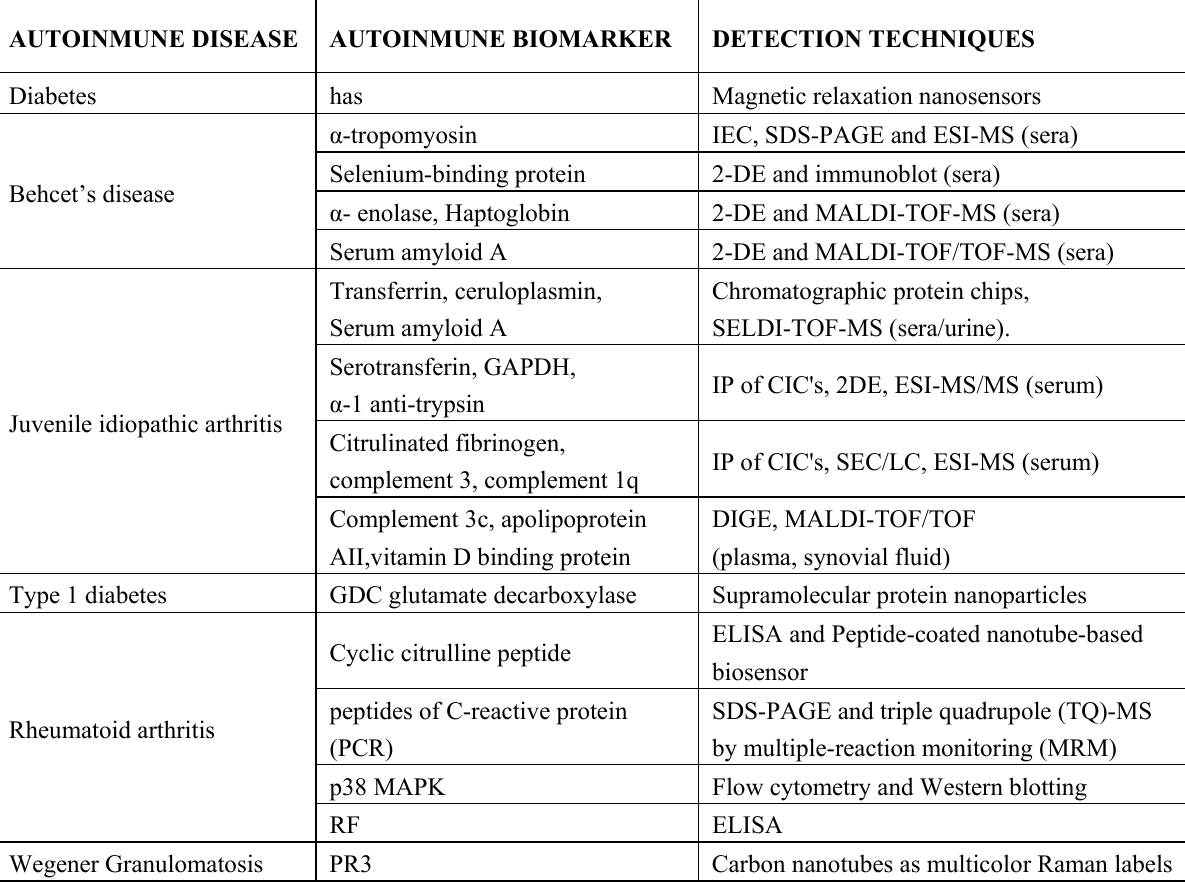
Table 2. A list of autoimmune biomarkers detected by novel sensors based on nanoproteomics